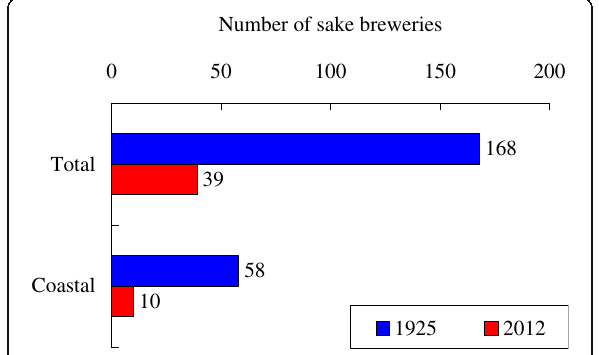
Fig. 6 Numbers of sake breweries, total and coastal, in Chiba Prefecture in 1925 and